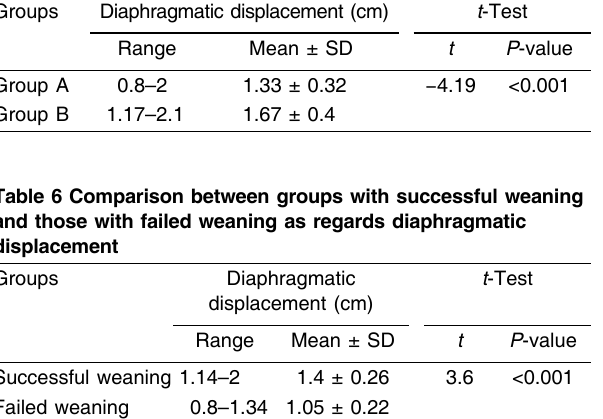
Table 7 Validity of different parameters in prediction of weaning status Variables Area under the